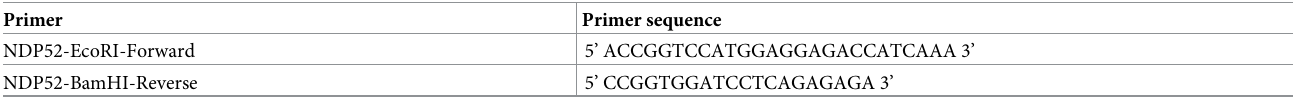
Table 4. Cloning Primers.